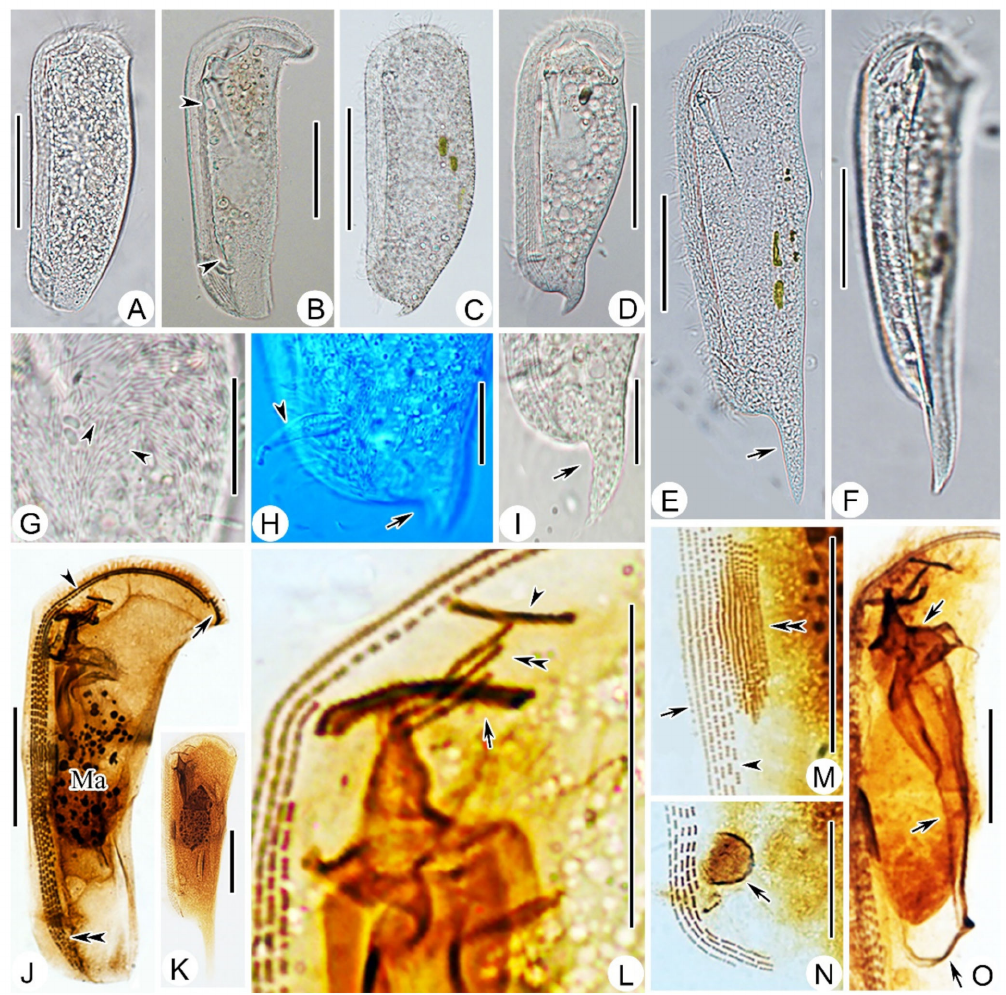
Figure 4. Photomicrographs of Dysteria brasiliensis in vivo (Ningbo population-II ( A ), Ningbo population-III ( B ), Ningbo population-V ( C , H ), Ningbo population-I ( D , G ), Ningbo population- IV ( E , F ), and after protargol staining ( J – O ). ( A ) Left lateral view of representative individual. ( B ) Left lateral view, to show the absence of a dorsal spine, and that anterior portion is distinctly wider than other parts of cell; arrowheads point to contractile vacuoles. ( C – E ) Left lateral view, to show the variable cell outline and with different-length dorsal spine (arrow). ( F ) Ventral view. ( G ) Arrowheads indicate rod-shaped bacteria on cell surface. ( H , I ) Left lateral view showing different-length dorsal spine (arrows) and podite (arrowhead). ( J , K ) Lateral views of two different specimens showing infraciliature; arrow shows equatorial fragment; arrowhead marks frontoventral kineties; double ar- rowhead points to right kineties. ( L ) Oral ciliary pattern; arrow shows circumoral kineties; arrowhead marks preoral kinety; double arrowhead points to left front kineties. ( M ) Ciliary pattern of midbody region; arrow shows equatorial fragment; arrowhead marks right kineties; double arrowhead points to left kineties. ( N ) Posterior end of ventral groove; arrow shows glandule. ( O ) Lateral view of oral region; arrow shows the winding of the cyrtos. Ma, macronucleus. Scale bar = 50 µ m ( A – F , G , K ); 20 µ m ( G – I , L – O